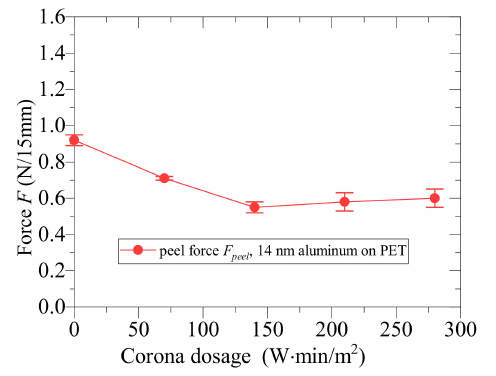
Figure 4. E ff ect of corona dosage on the peel force of aluminum-coated PET films. The thickness of the aluminum coating was 14 nm (also see Figure 5c). Each value is a mean of n = 5 measurements ± standard